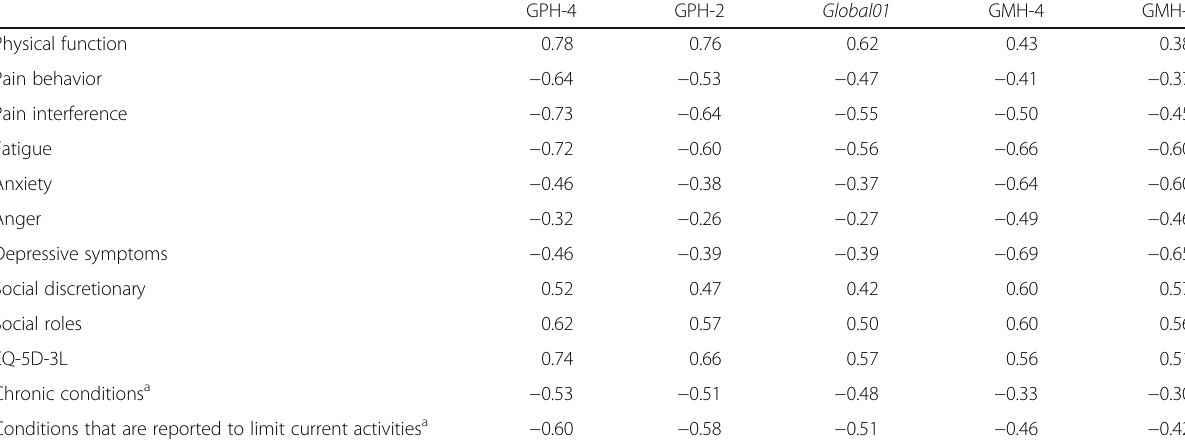
Table 2 Product-moment correlations with PROMIS Global Health